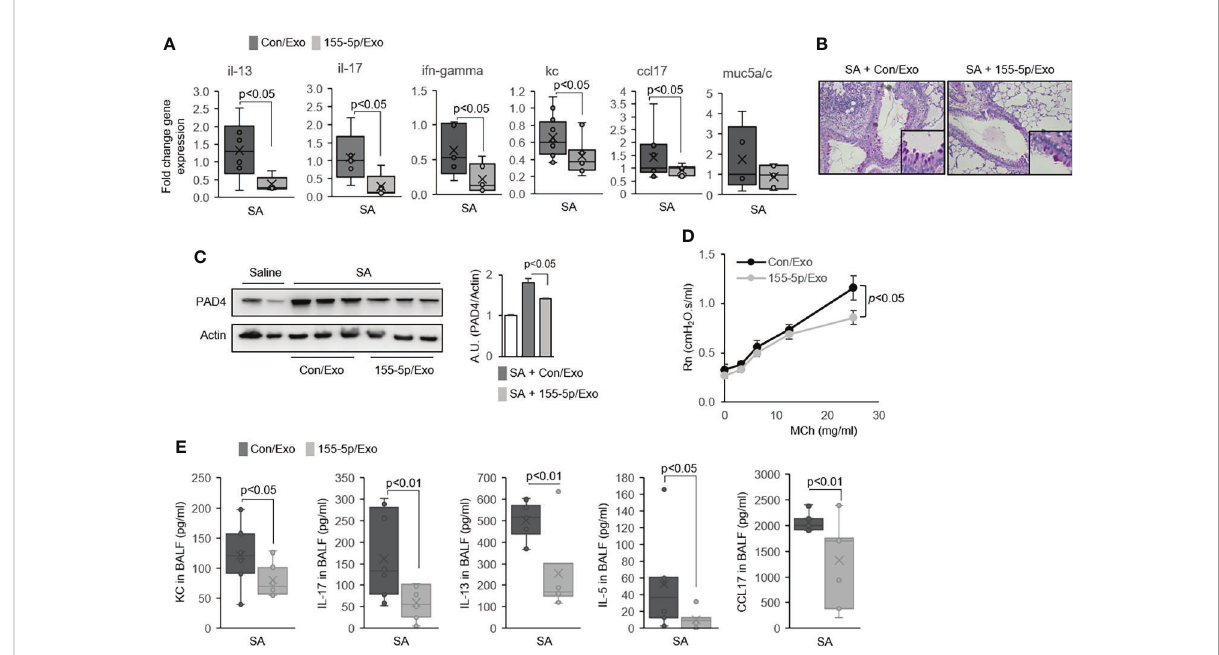
FIGURE 5 MiR-155 inhibition alters eosinophilic and neutrophilic in fl ammation in the airways of severe asthma (SA) mice. (A) The mRNA expression in lung tissues from Con/Exo- and 155-5p/Exo-treated mouse lungs subjected to the SA model (N = 5 – 7). (B) Representative histologic lung sections stained with PAS. Boxed regions are shown enlarged at right. (C) Expression of PAD4 as determined by Western immunoblot. (D) Airway hyperresponsiveness (AHR) in Con/Exo- and 155-5p/Exo-treated mice subjected to the SA model. (E) The level of cytokines in BALF (N = 5 – 7). Graphs were plotted as mean ± SE. p-Values were obtained using a two-tailed Student ’ s t-test. PAS, periodic